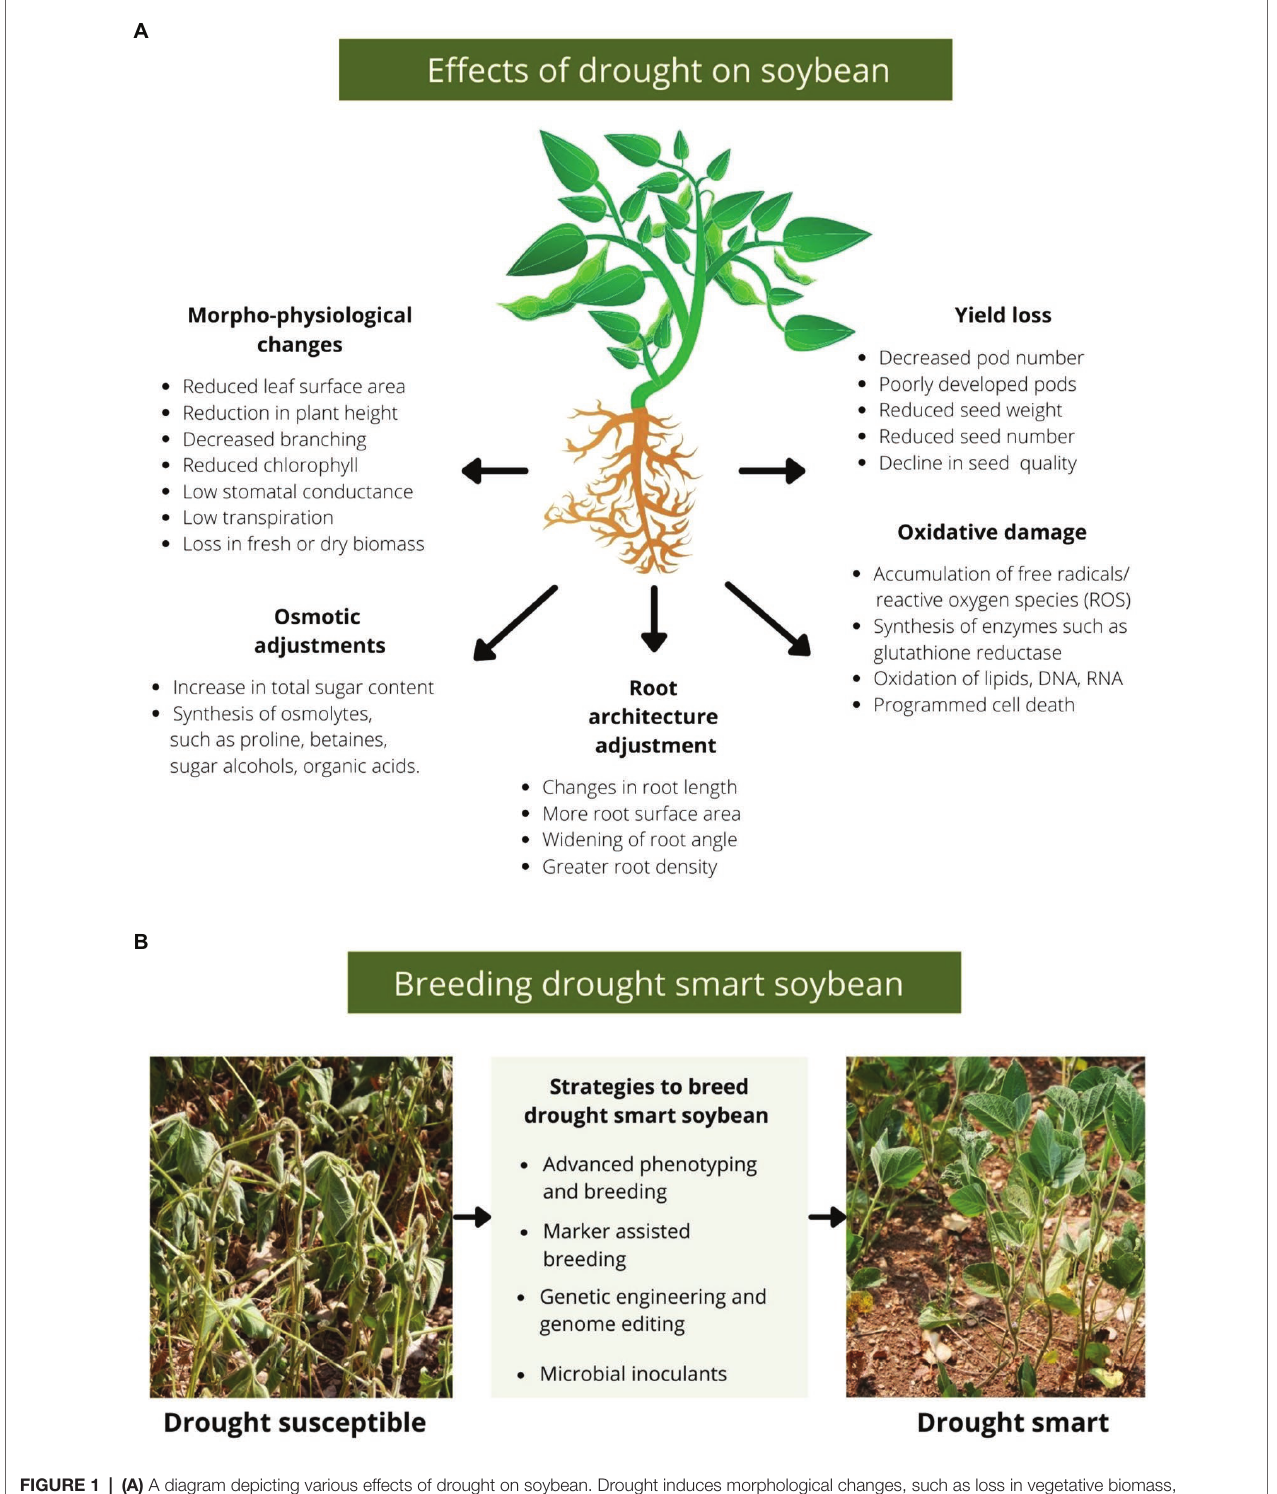
FIGURE 1 | (A) A diagram depicting various effects of drought on soybean. Drought induces morphological changes, such as loss in vegetative biomass, accompanied by a reduction in pod number, seed number, seed weight and altered biochemical composition of seeds. Further, cells regulate the effect of drought, synthesising osmolytes, such as proline and sugar alcohols, to balance the osmotic potential for maintaining cell membrane integrity. Also, in many drought-resistant soybean cultivars, roots adjust their architecture in response to water-deficit conditions by changing root length, branching and other phenotypes to absorb more soil moisture. Further, severe drought stress leads to ROS accumulation which can cause cell and tissue damage by oxidising biomolecules. (B) An outline of strategies to breed drought-smart